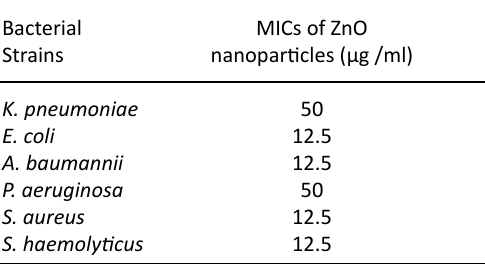
Table 5. Minimum inhibitory concentration (MIC) against bacterial strains